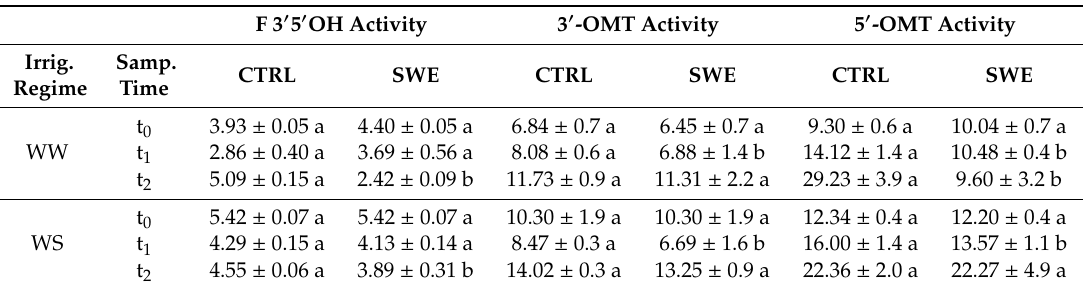
Table 3. Enzymatic activities computed as ratios of anthocyanin amounts in berry skin of V. vinifera treated with A. nodosum extract (SWE) and untreated plants (CTRL), under two irrigation regimes (WW, well-watered; WS, water